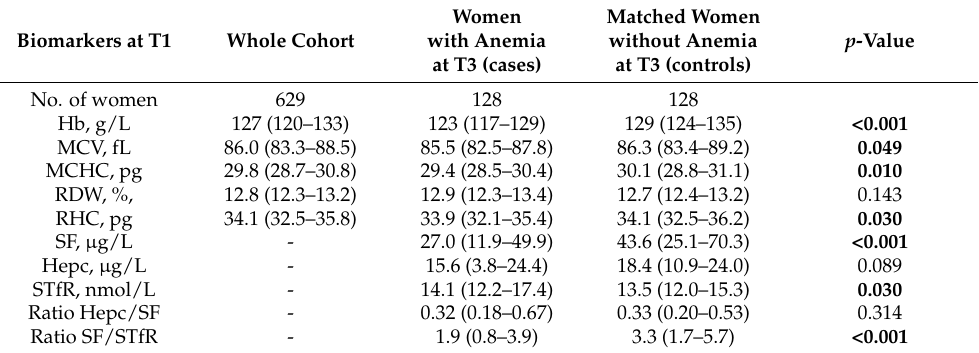
Table 3. Biomarkers at first trimester of pregnancy (T1) of pregnant women of the whole cohort, women with anemia at third trimester of pregnancy (T3) (cases) and women without anemia at T3